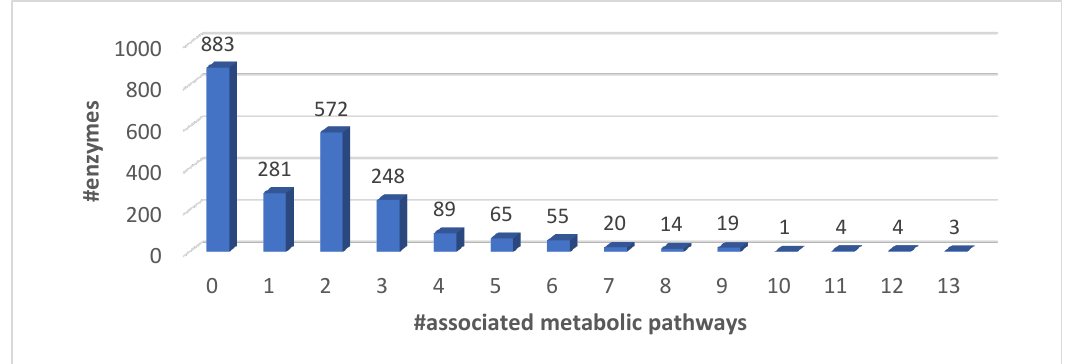
Figure 2. Distribution of EC proteins as a function of KEGG metabolic pathways.